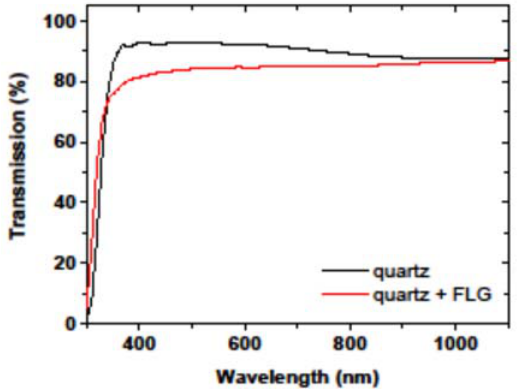
Figure 6. Optical transmission spectra of a quartz slide and the few ‐ layer graphene sample on top of quartz.